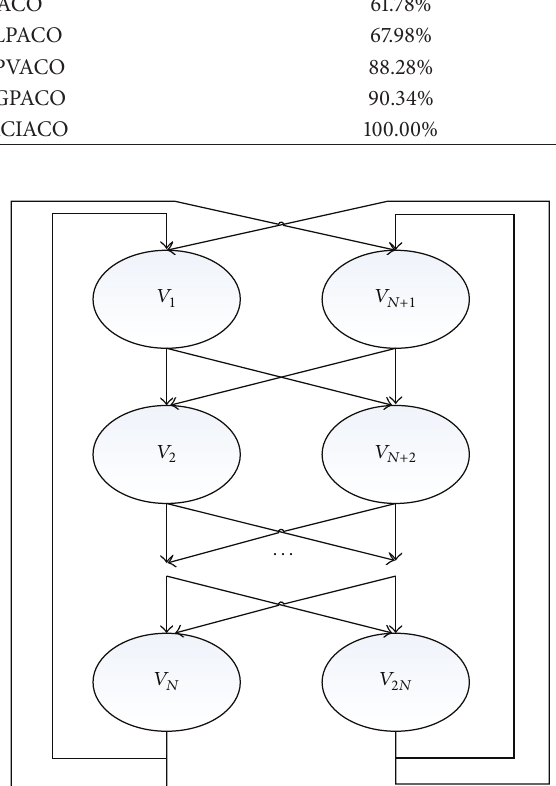
Figure 5: Ant colony path model.